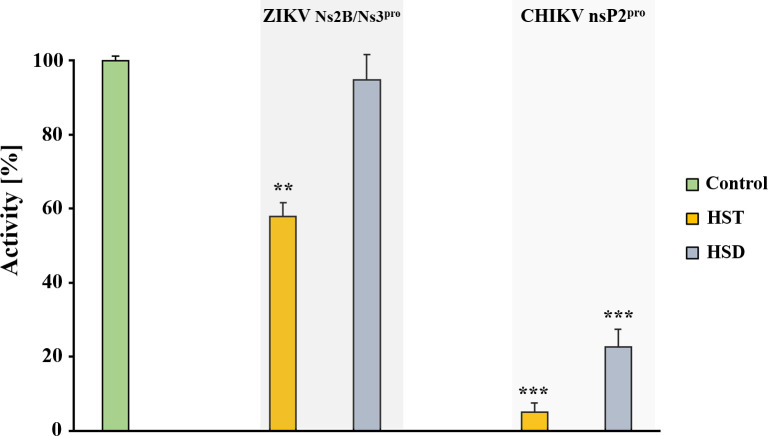
Preliminary inhibition test of HST and HSD against ZIKV NS2BNS3pro and CHIKV nsP2pro.The tested compound concentration was 20 µM. HST inhibit ZIKV NS2B/NS3pro activity about 40% and CHIKV nsP2pro about 90%. The inhibition of CHIKV protease activity by HSD was higher than 60%. Contrary, HSD shows not relevant inhibition against ZIKV NS2B/NS3pro. Data shown are the means ± SD from three independent measurements (n = 3). Asterisks mean that the data differs from the control (0 µM inhibitor) significantly at p < 0.01 (**) and p< 0.001 (***), level according to ANOVA and Tukey’s test.